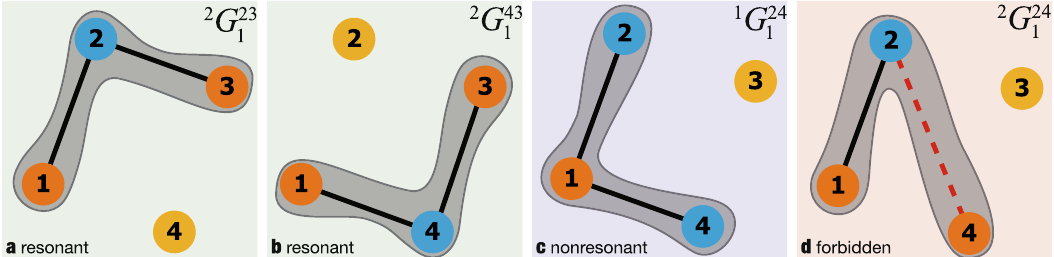
Fig. 2 | Emergent higher-order interactions from the original ring network. Coupling functions appearing in Eq. (12) of node 1. Colors correspond to signs in the phase combination with blue standing for positive and orange for negative. a Resonant interaction term appearing as 2 G 23 1 . b Resonant interaction term